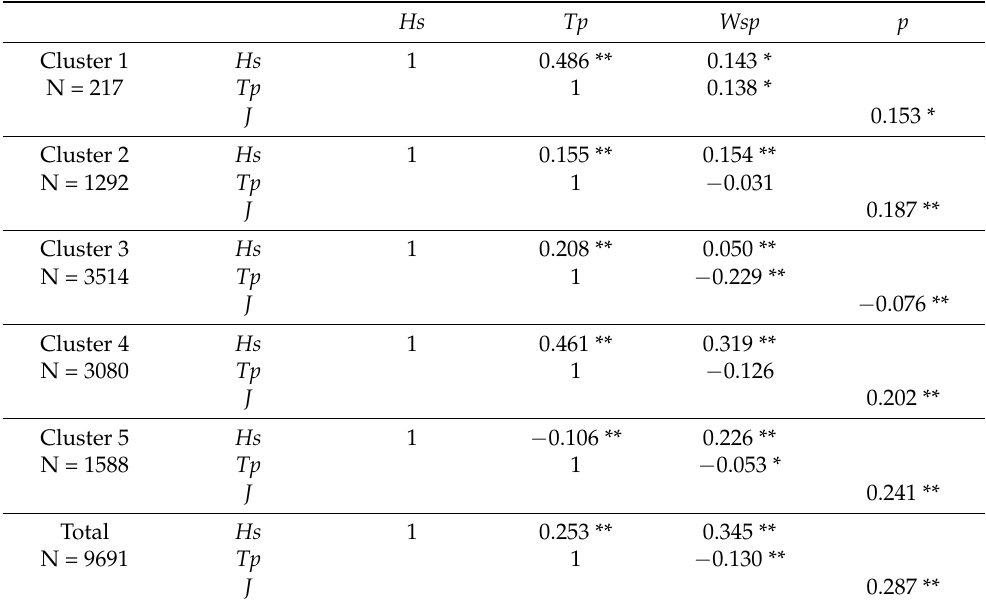
Table 3. Correlation coefficient between wind and wave parameters and the energy density of different clusters. Hs Tp Wsp p Cluster 1 Hs 1 0.486 ** 0.143 * N = 217 Tp 1 0.138 * J 0.153 * Cluster 2 Hs 1 0.155 ** 0.154 ** N = 1292 Tp 1 − 0.031 J 0.187 ** Cluster 3 Hs 1 0.208 ** 0.050 ** N = 3514 Tp 1 − 0.229 ** J − 0.076 ** Cluster 4 Hs 1 0.461 ** 0.319 ** N = 3080 Tp 1 − 0.126 J 0.202 ** Cluster 5 Hs 1 − 0.106 ** 0.226 ** N = 1588 Tp 1 − 0.053 * J 0.241 ** Total Hs 1 0.253 ** 0.345 ** N = 9691 Tp 1 − 0.130 ** J 0.287 ** * Correlation at the confidence level of 95%. ** Correlation at the confidence level of